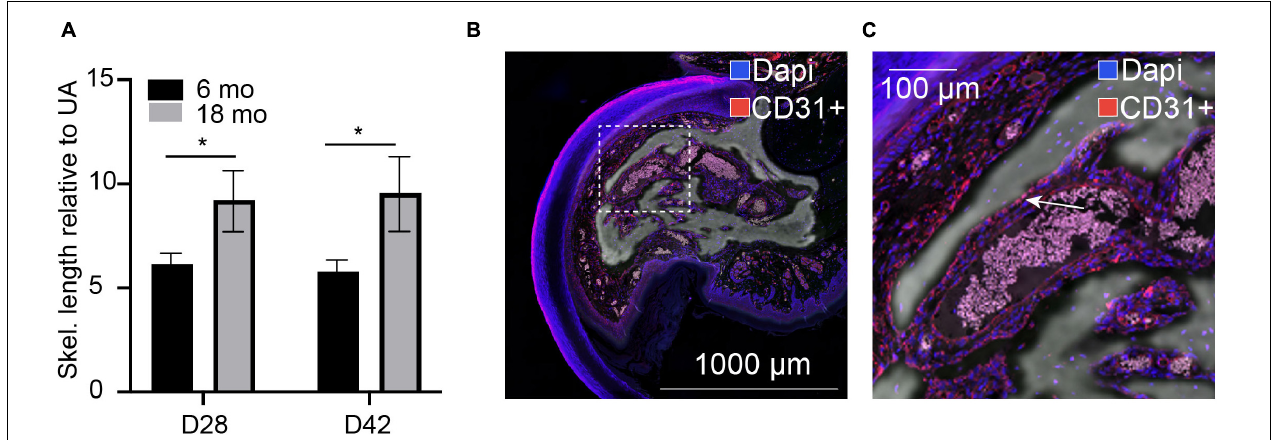
FIGURE 1 | Internal void space. (A) Skeletonization of the internal vascular space of the regenerated digit at day 28 and day 42 relative to the unamputated skeletonization length in 6-month-old and 18-month-old mice. *indicates p < 0.05. N = 11–14 digits. Data are represented as mean ± SEM. (B,C) Void spaces are lined with CD31-positive cells. CD31 (red), dapi (blue). Inset shows (C) close-up CD31-positive area. Arrow indicates CD31 + cells. Representative sample shown: 18-month D42, N = 3. Scale bar = 1,000 µ m.